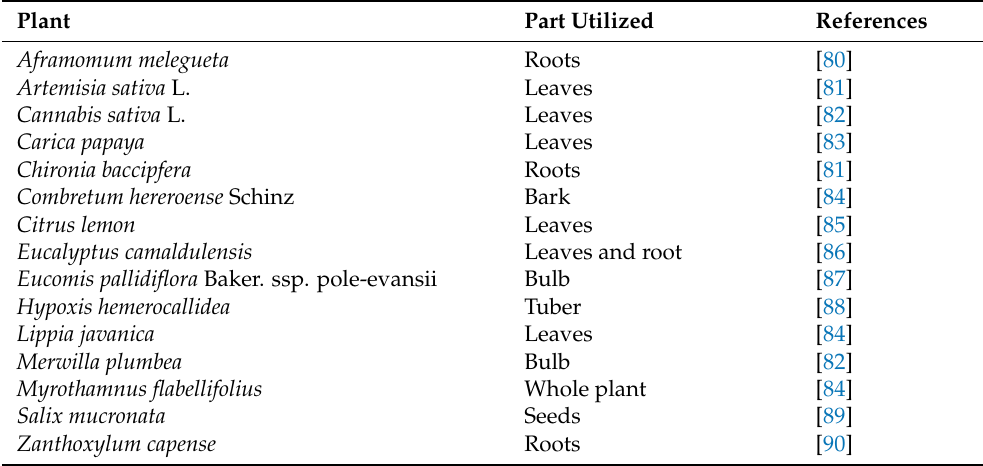
Table 3. Plants with known anti-tubercular activity. Their anti-tubercular principles are yet to be